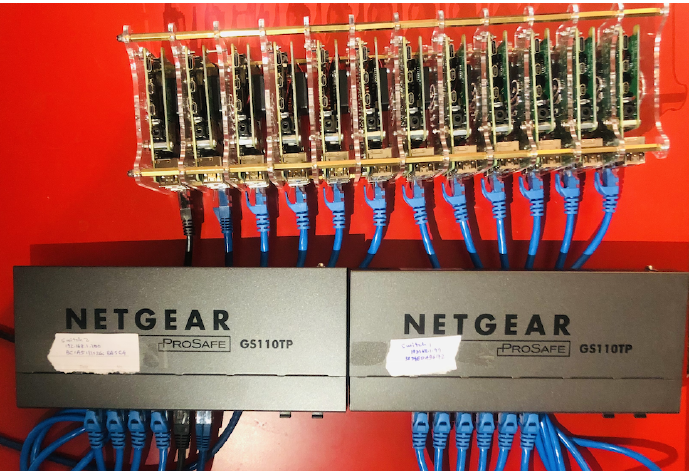
Figure 1. Computing Nodes